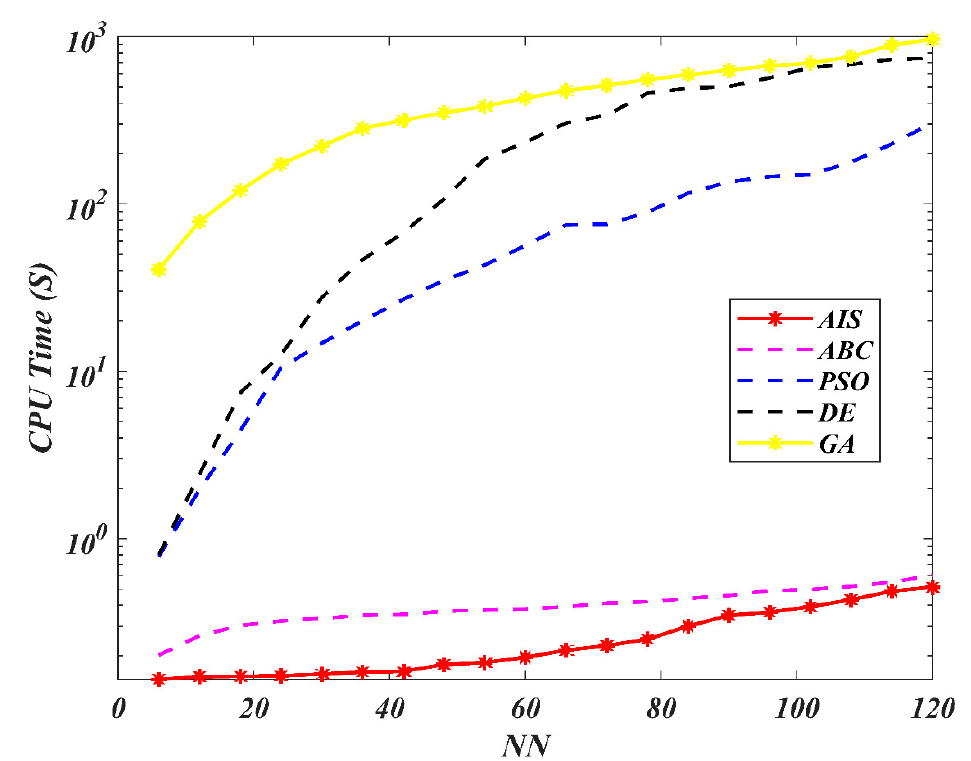
Figure 24. CPU time Evaluation for Hepatitis.